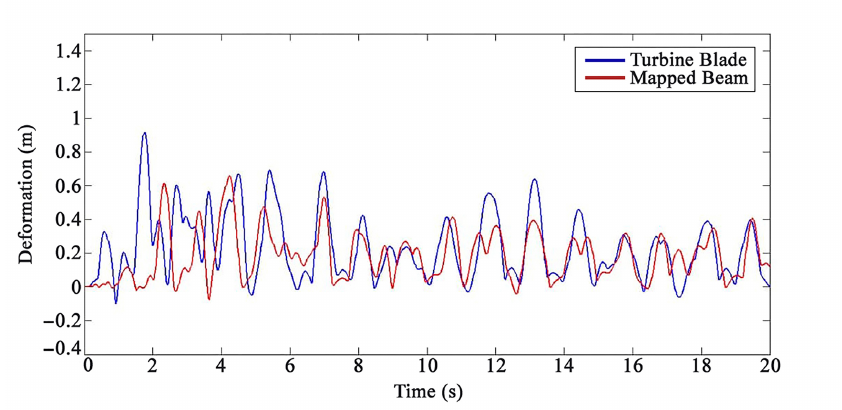
Figure 6. The outcomes of the analytical results and FEM results for the thirty-fifth sensor under loading number 2 (30 degrees attack